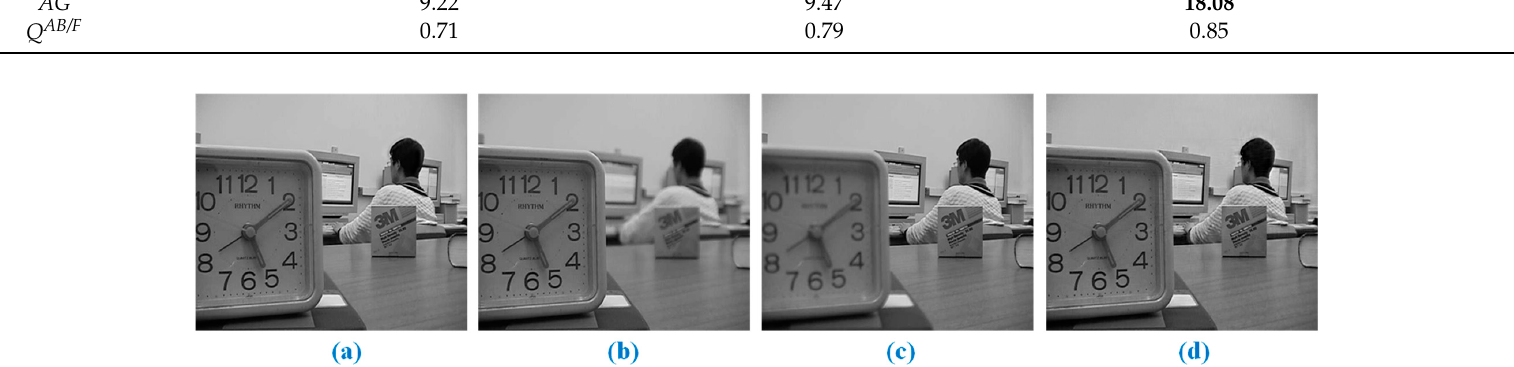
Evaluation Metric Liu et al. Samet Aymaz et al. without SR Samet Aymaz et al. SR Proposed Method